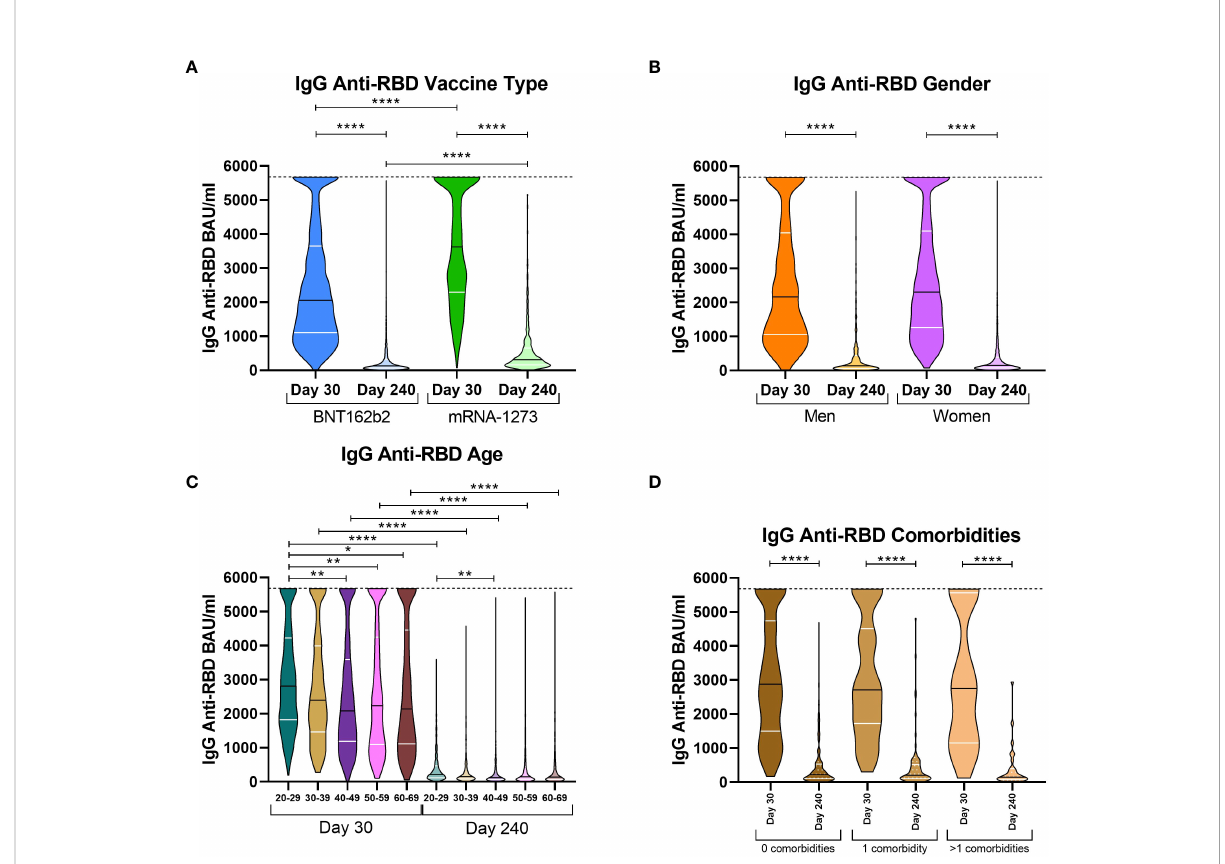
FIGURE 1 IgG anti-RBD levels on day 30 and 240 strati fi ed by vaccine type, gender, age, and comorbidities. Violin plots of IgG anti-RBD levels in BAU/ml strati fi ed according to vaccine type [ (A) mRNA-1273 or BNT162b2]; gender [ (B) male or female]; age ranges [ (C) from 20 to 29 years old, 30-39 years, 40-49 years, 50-59 years, and 60-69 years]; and the presence of comorbidities [ (D) no comorbidities, one comorbidity, or more than one comorbidity]. The median (black line) and quartiles (white lines) are represented in each violin plot. IgG anti-RBD levels were calculated in international units (BAU/ml). On day 30, the dotted line at 5,680 BAU/ml indicates the higher limit of quanti fi cation. A Kruskal Wallis test and a Dunn ’ s multiple comparisons test were performed for each variable. * p-value < 0.05, ** p-value < 0.01, **** p-value <